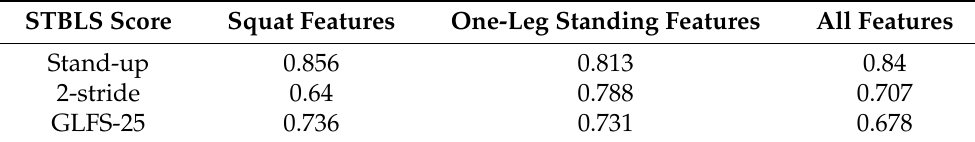
Table 8. Maximum accuracies ( R 2 ) achieved through the Random Forest